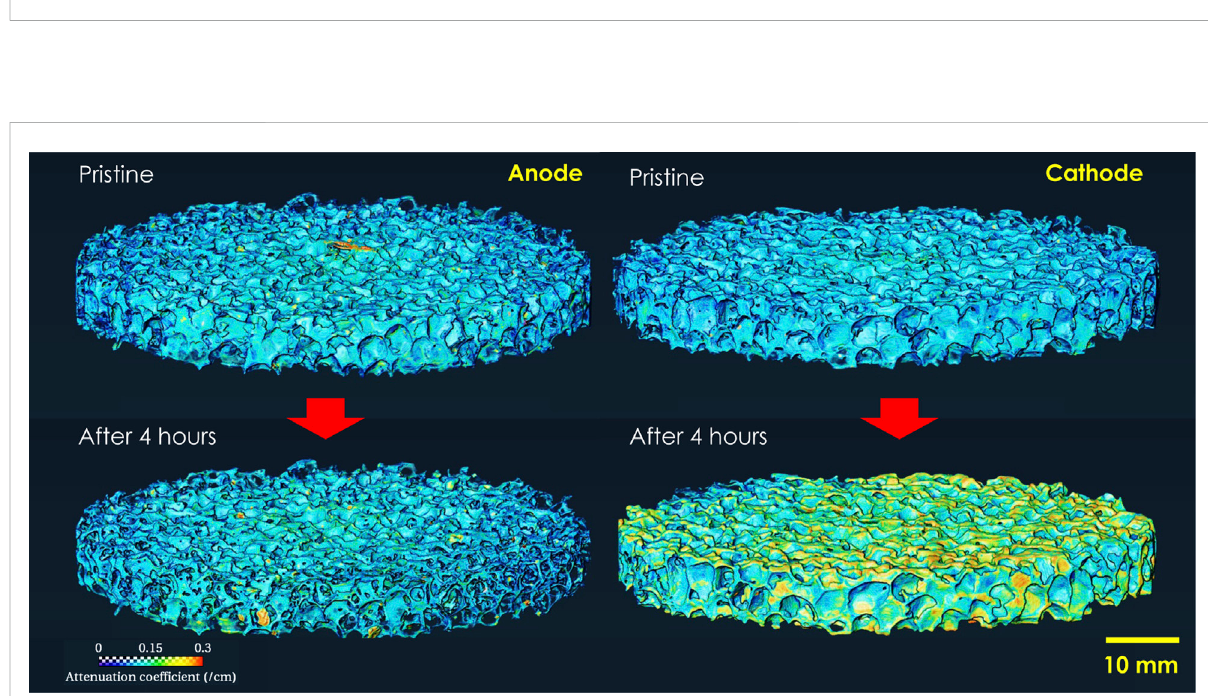
FIGURE 2 Reconstructed 3D volume of porous Al foam electrodes before and after a 4-h electrocoagulation experiment.